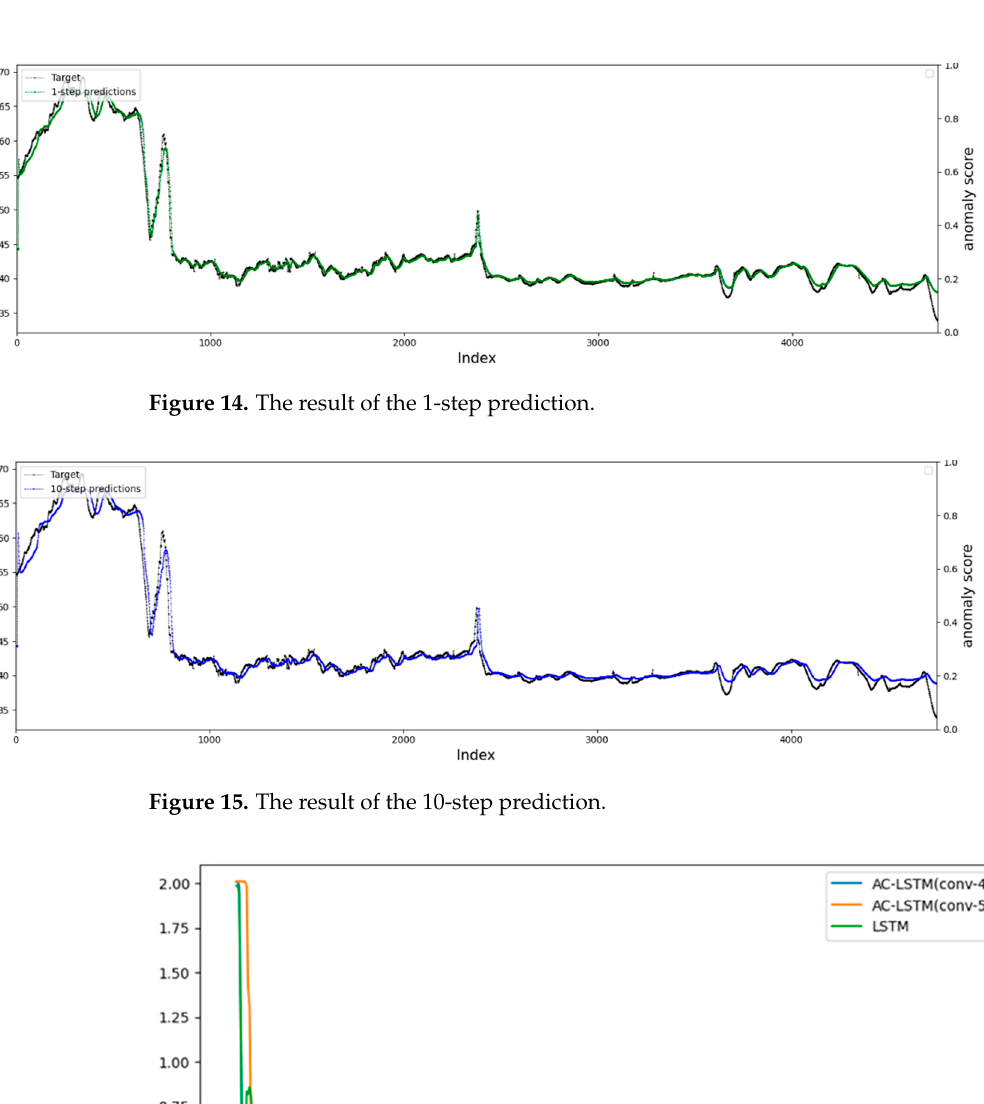
Figure 14. The result of the 1-step prediction.